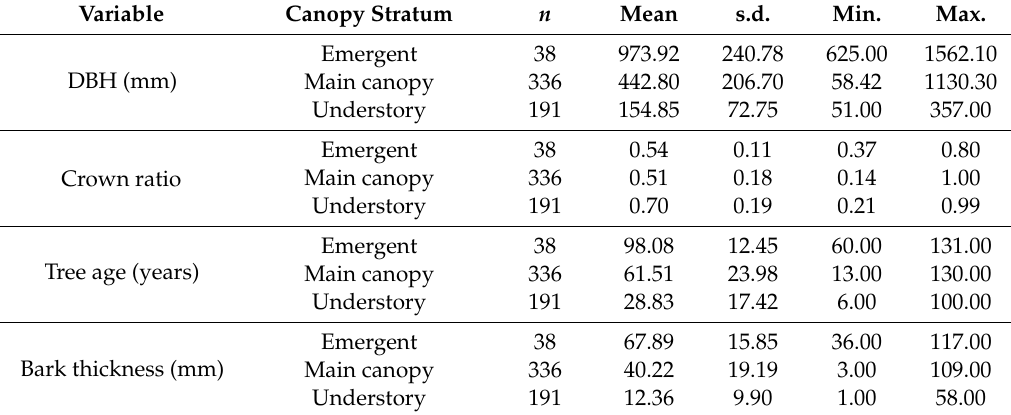
Table 11. Summary data for redwood trees separated into three canopy layers (strata) in even-aged and multiaged stands. Data for trees with breast-height age data ( n = 565) collected in 48 plots sampling even-aged and multiaged stands in Jackson Demonstration State Forest.